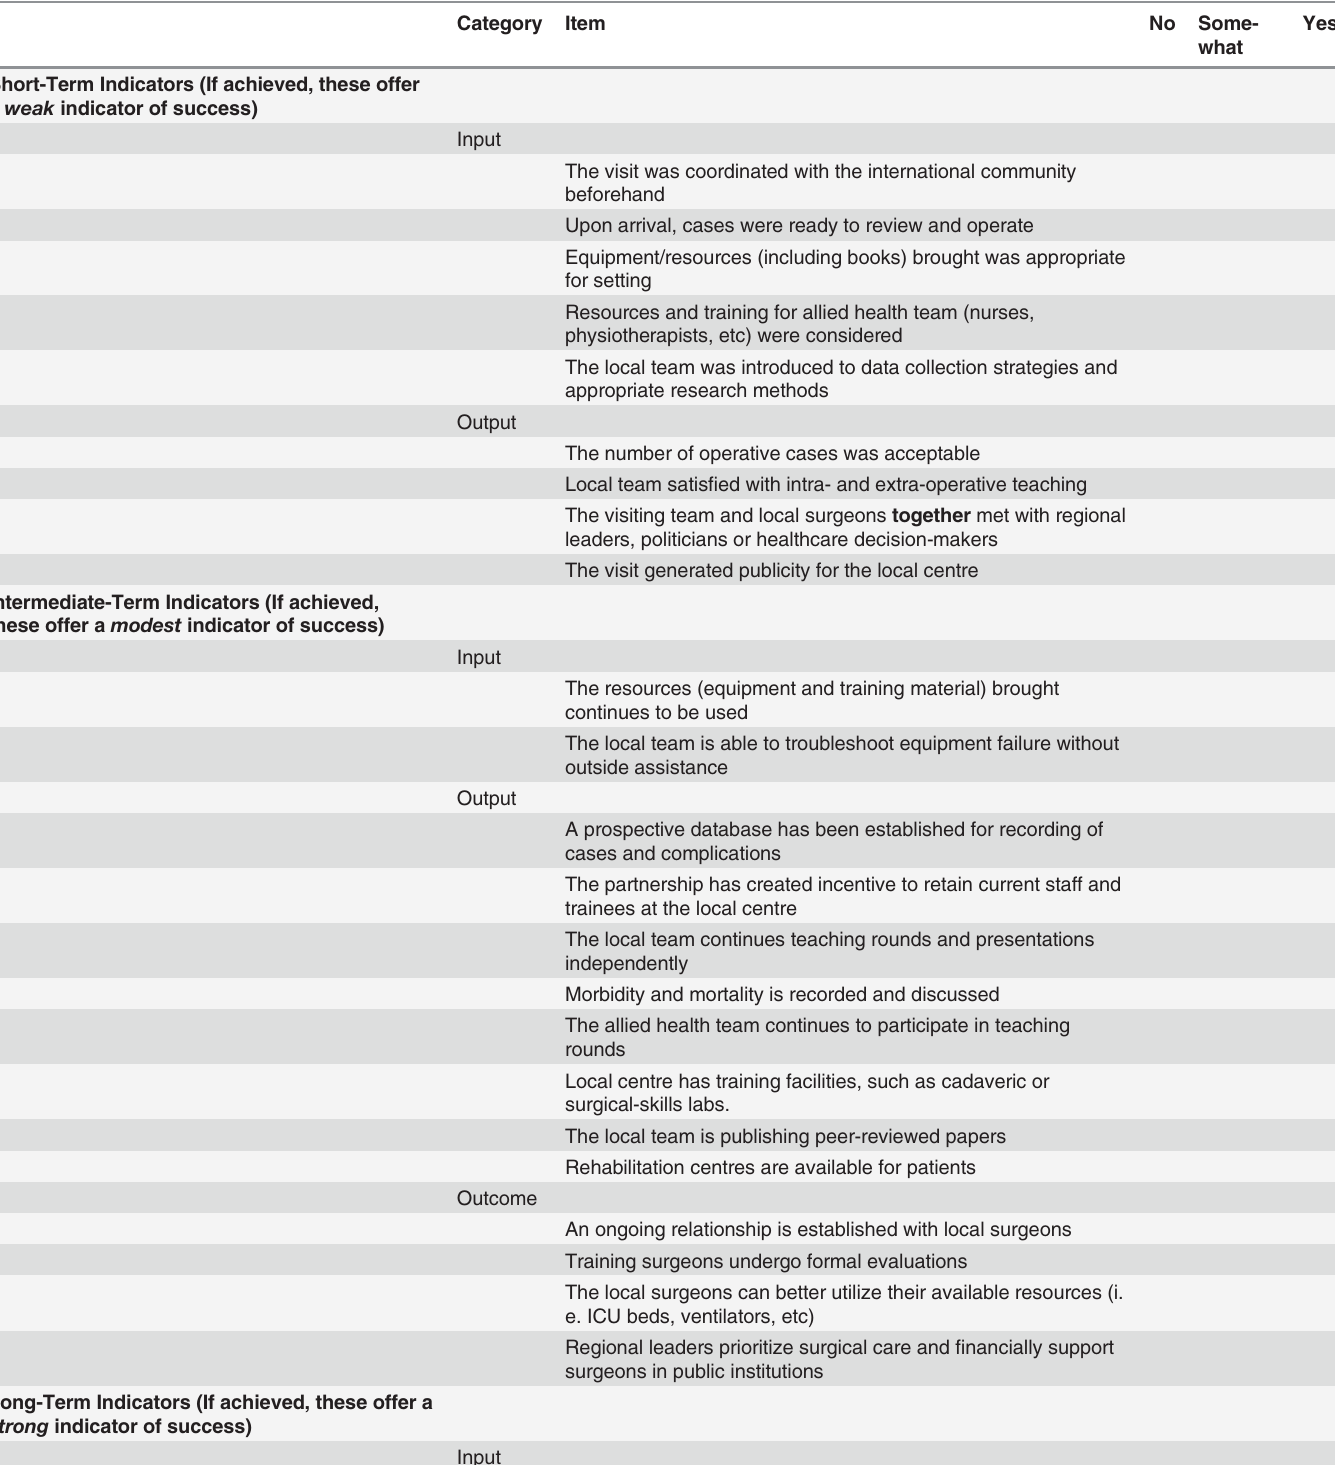
Table 1. The Framework for the Assessment of InteRNational Surgical Success (FAIRNeSS)